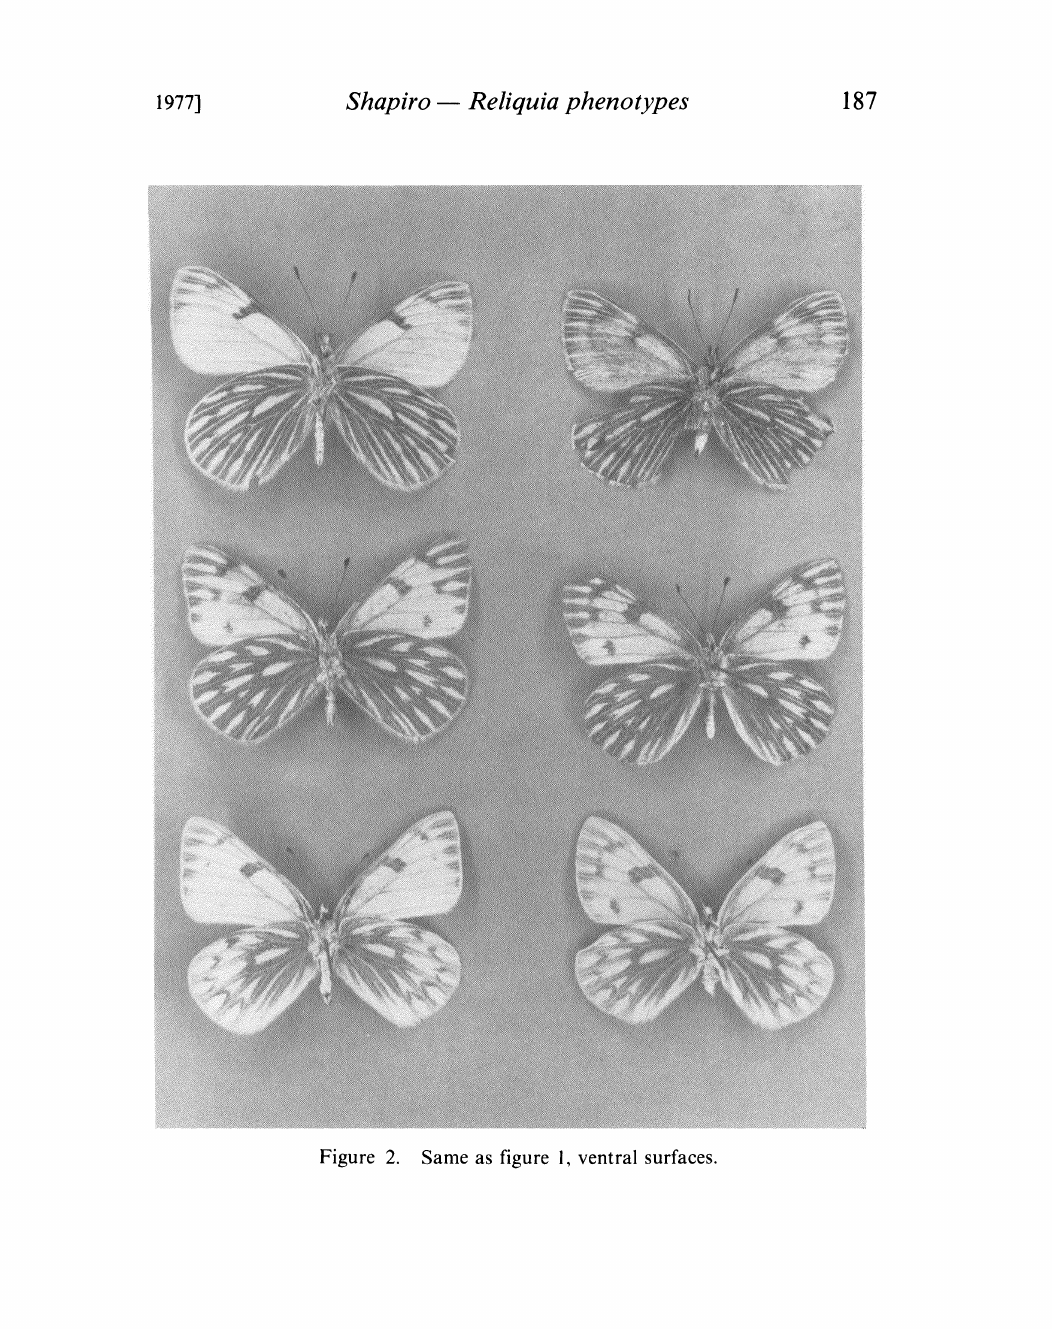
Figure 2. Same as figure l, ventral